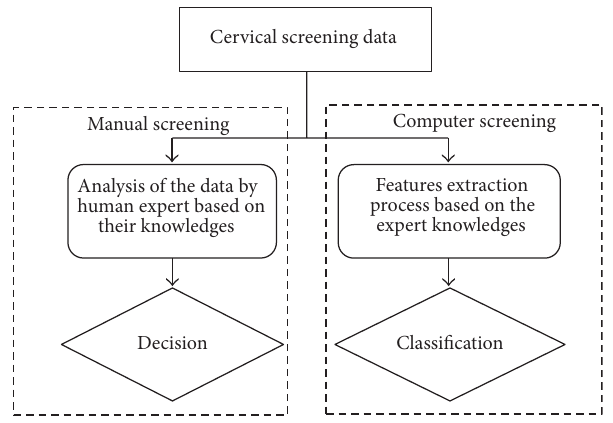
Figure 2: Comparison of analysis screening system by human expert and